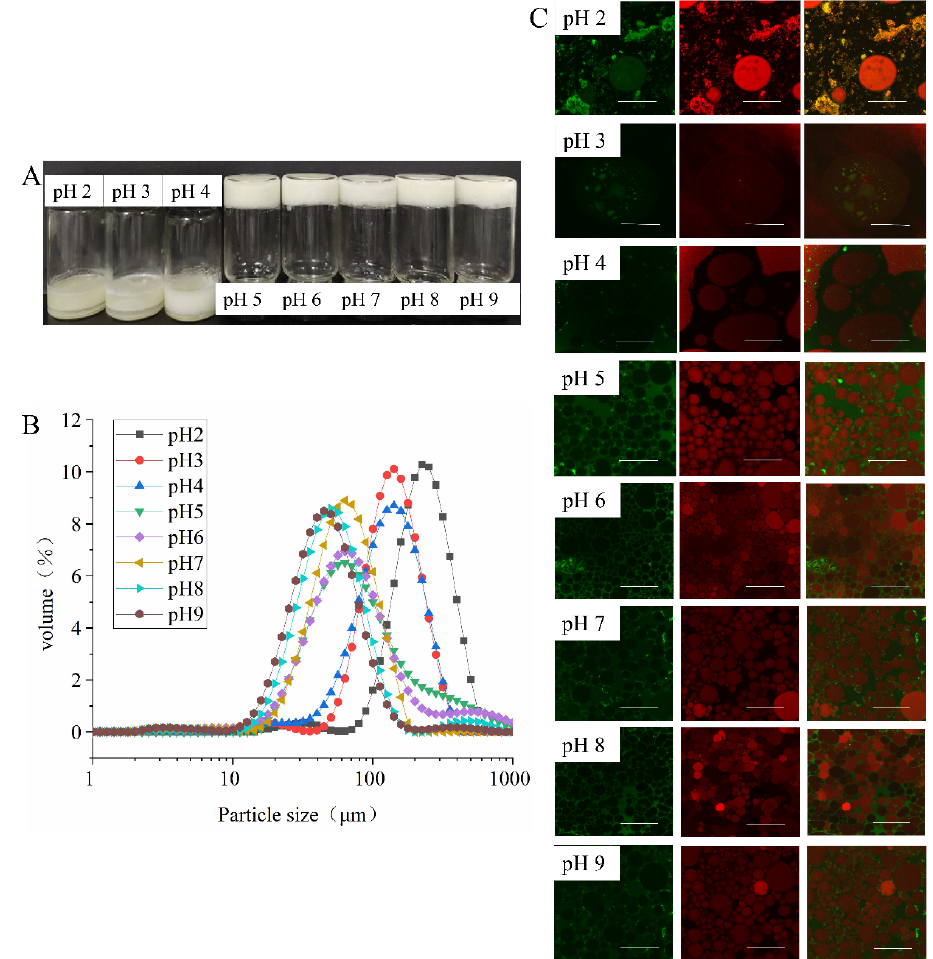
Figure 5. The visual observation ( A ), particle size distribution ( B ), and CLSM images ( C ) of HIPEs stabilized by EYGs at different pH. The concentration of EYGs was 3.0 wt%, the NaCl ionic strength was 0.3 M, and the volume of the oil phase was 0.8. The corresponding bar is 100 µm.